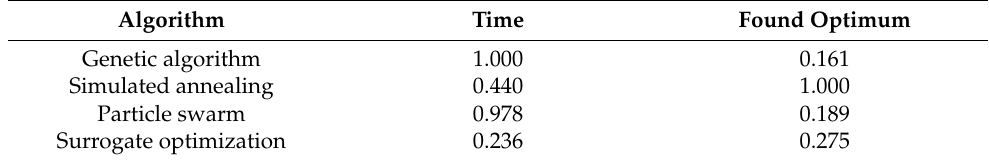
Table 1. Results of the preliminary study comparing common heuristics in task of obtaining Jansen Rit (J-R) model parameters. Values of time and optimum are normalized to the highest value.